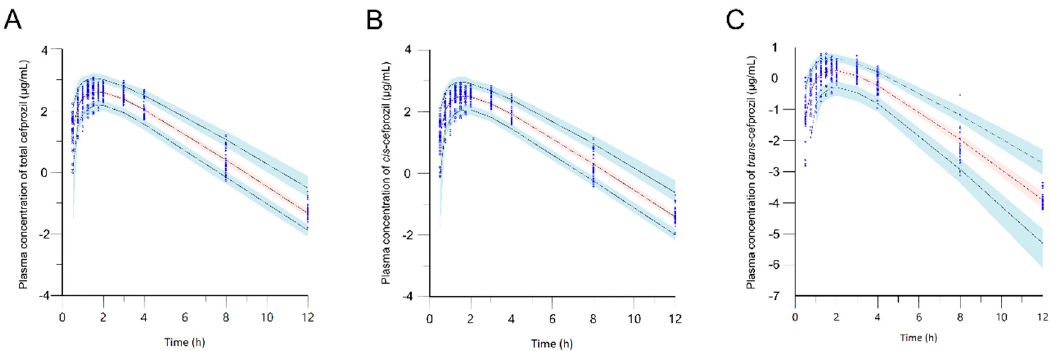
Figure 5. Visual predictive check of the final model for total cefprozil ( A ), cis -cefprozil ( B ), and trans -cefprozil ( C ). Dots indicate observed concentrations. Black dashed lines represent 5th, 50th, and 95th percentiles of the predicted concentrations; Blue shaded regions are 95% confidence intervals for predicted 5th and 95th percentiles. Red shaded regions are 95% confidence intervals for the predicted 50th percentiles.